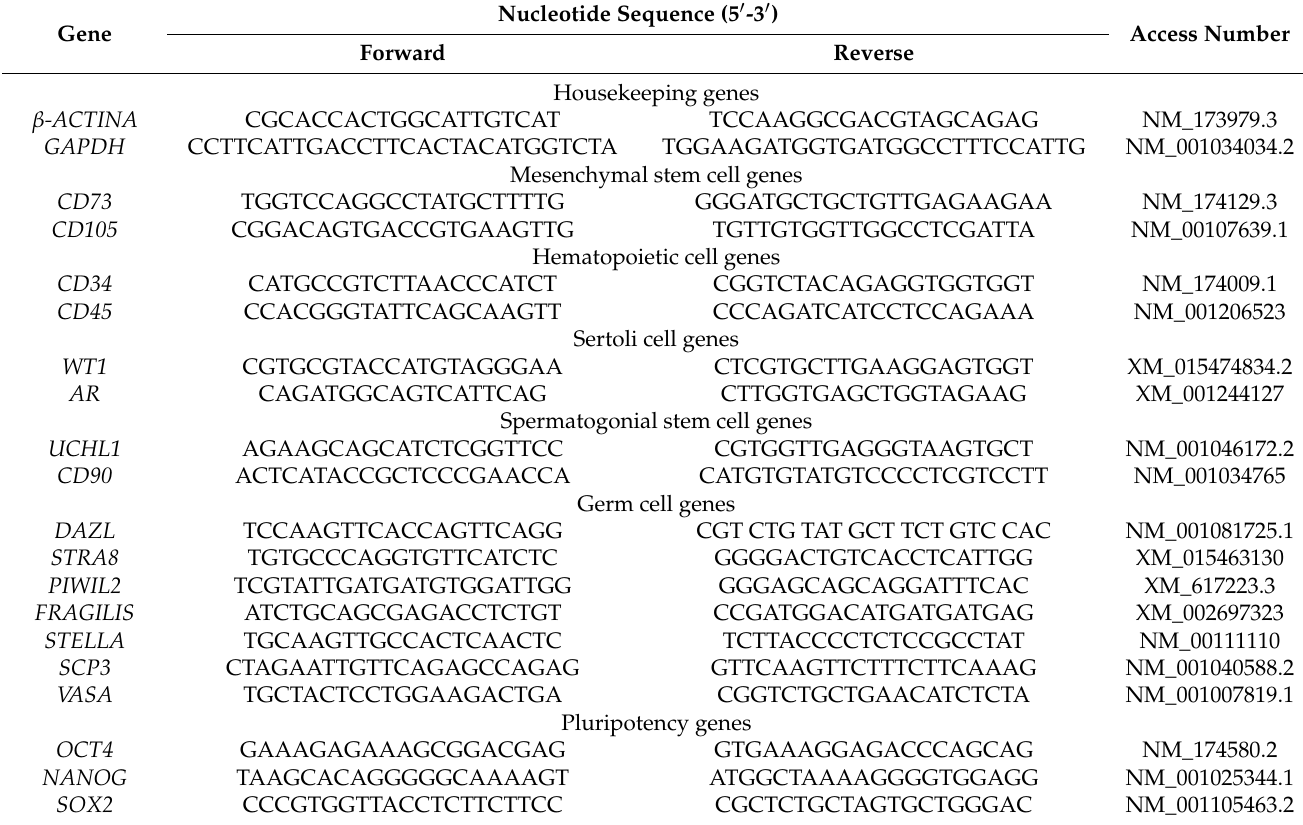
Table 1. Sequence of primers used for Q-PCR